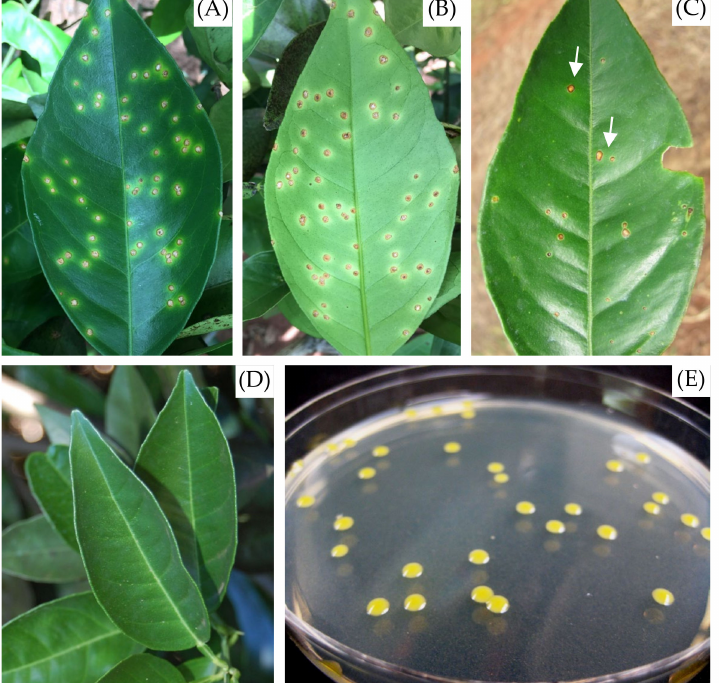
Figure 10. Treatments used to extract macromolecules for MALDI-TOF mass spectrophotometry analysis. Citrus canker lesions on the upper ( A ) and lower ( B ) surface of Citrus sinensis leaves: IT; necrotic lesions resulting from phytotoxicity due to the herbicide Paraquat ( C ): HP; healthy leaves ( D ): HT; and pure cultures of Xcc ( E ): PC. Arrows indicate necrotic lesions resulting from phytotoxicity due to the herbicide